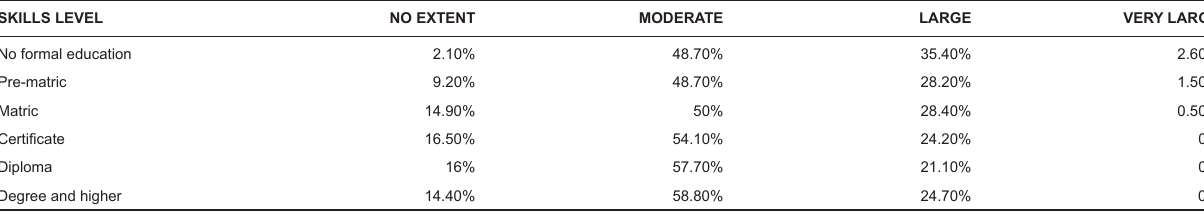
TABLE 6 Impact of HIV/AIDS on skills levels (% of respondents)